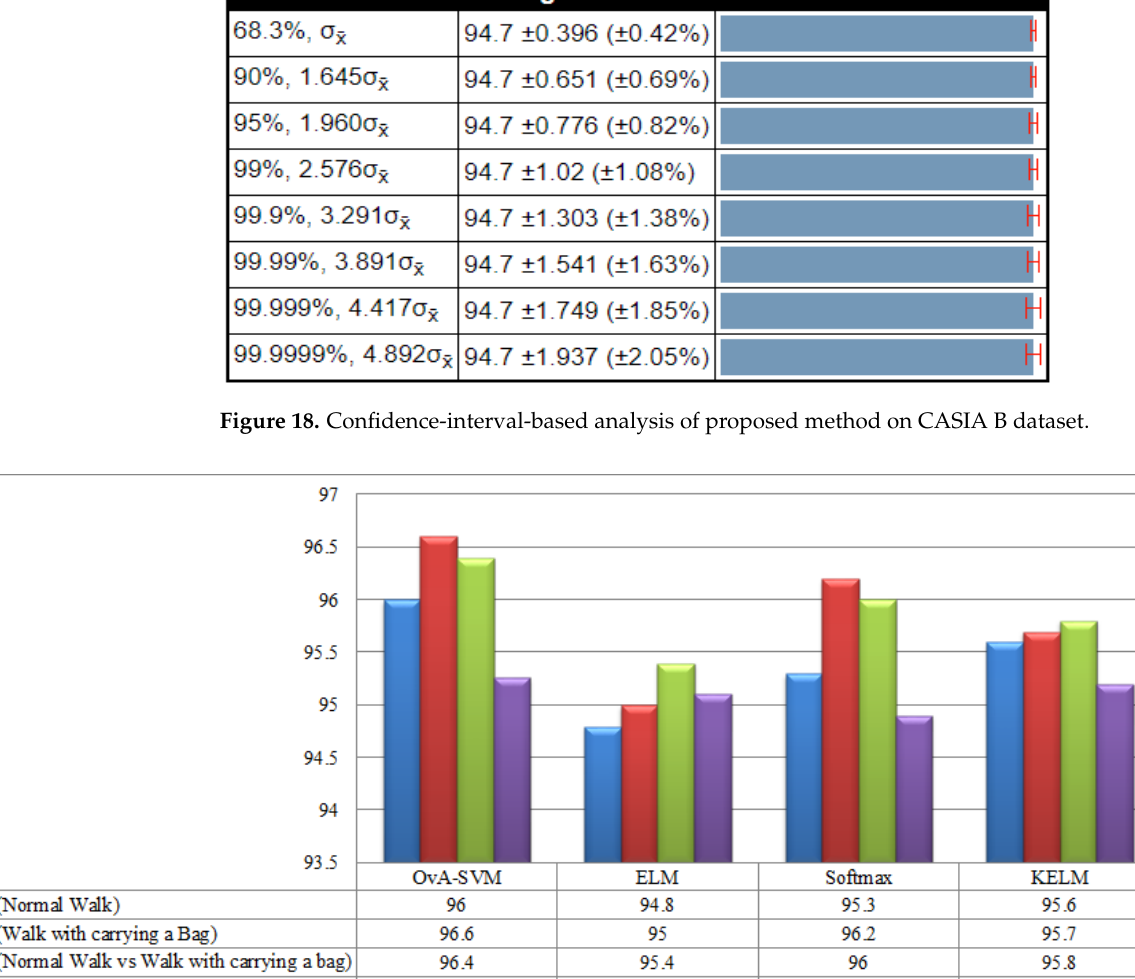
Figure 17. Confidence interval based analysis of proposed method on real-time dataset .